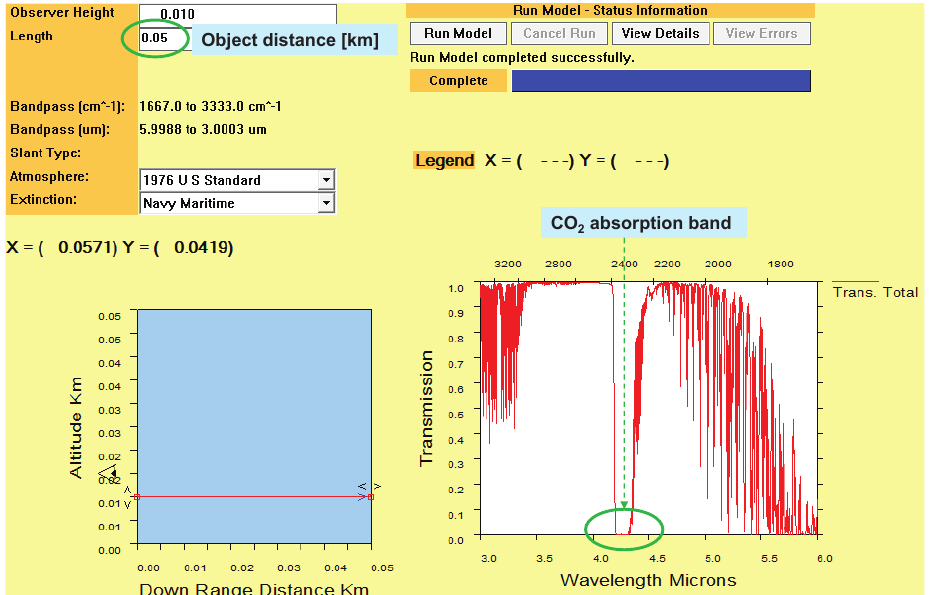
Figure 7. Atmospheric transmittance at the 50 m distance, and the characteristics of the CO 2 absorp- tion band (4.20–4.35 µ m).